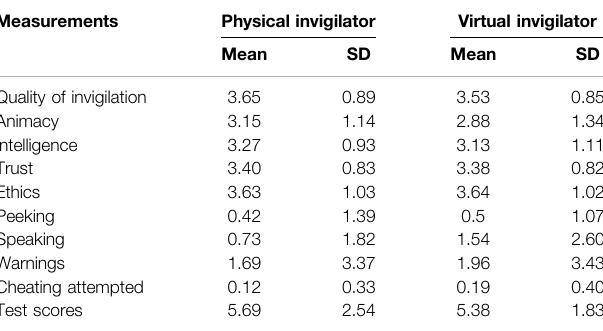
TABLE 4 | Measurements of study two: mean and SD.